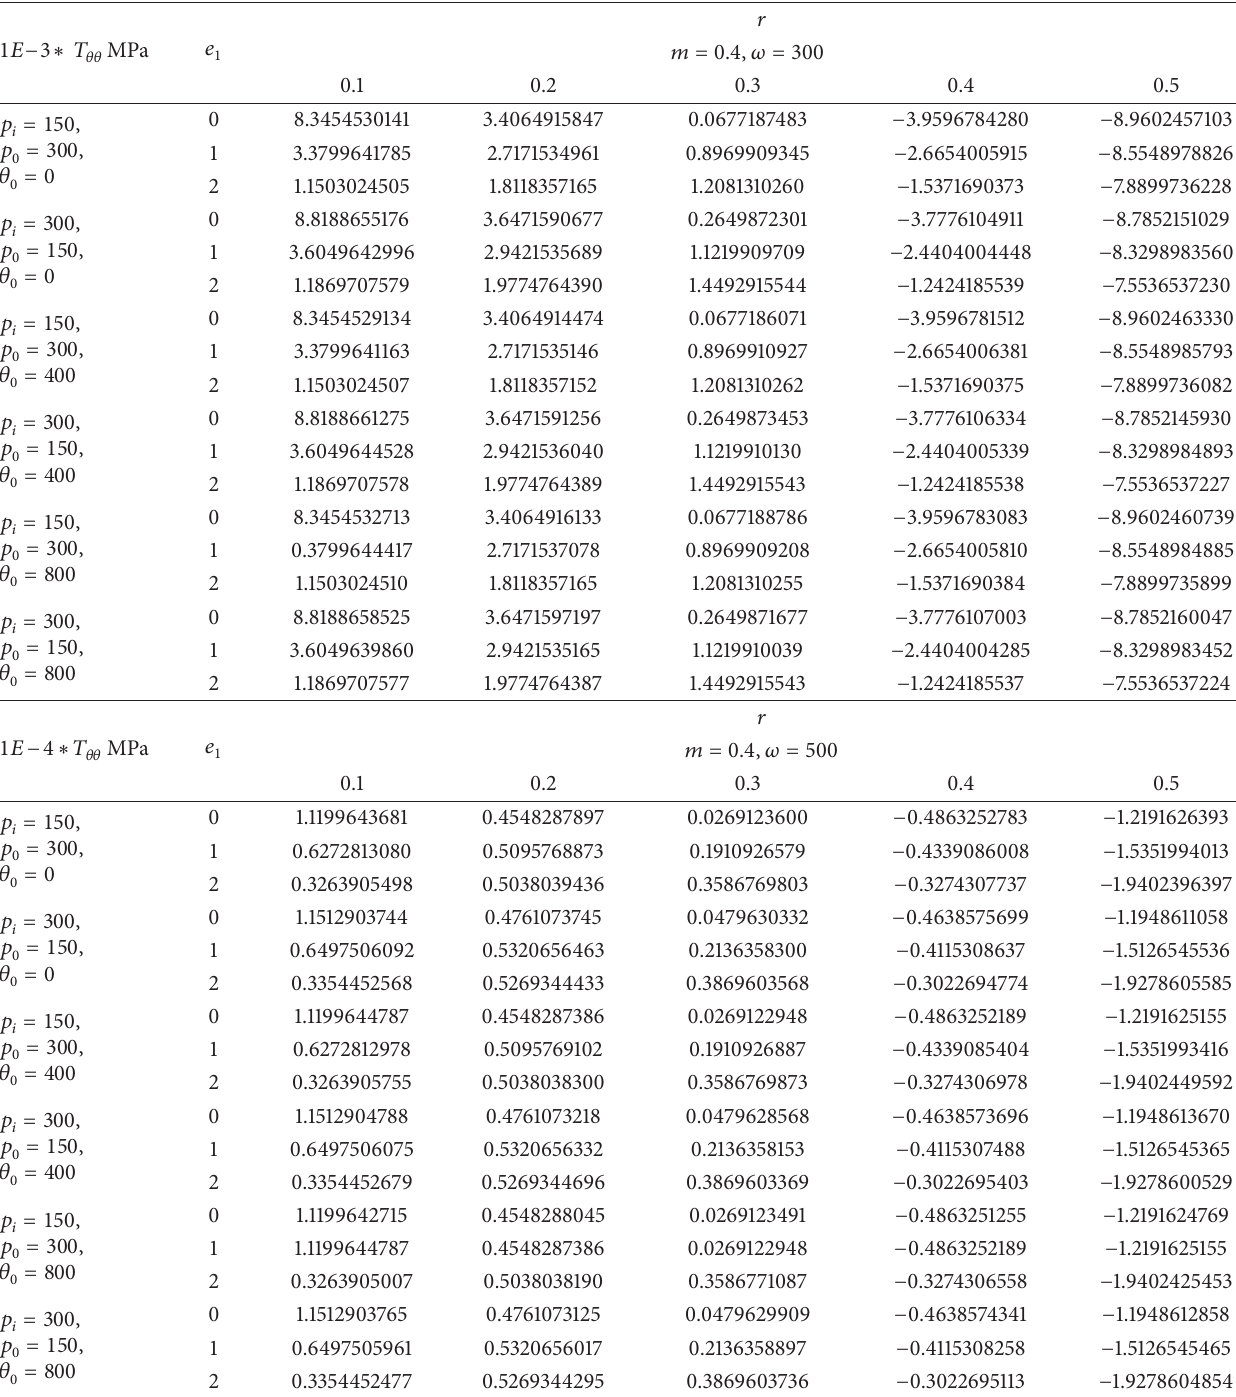
Table 1: Circumferential stresses for rotating cylinder with constant thickness and constant density, 𝜔 = 300, 500 , nonlinear strain hardening measure 𝑚 = 0.4 , and different parameters of Young’s modulus under internal and external